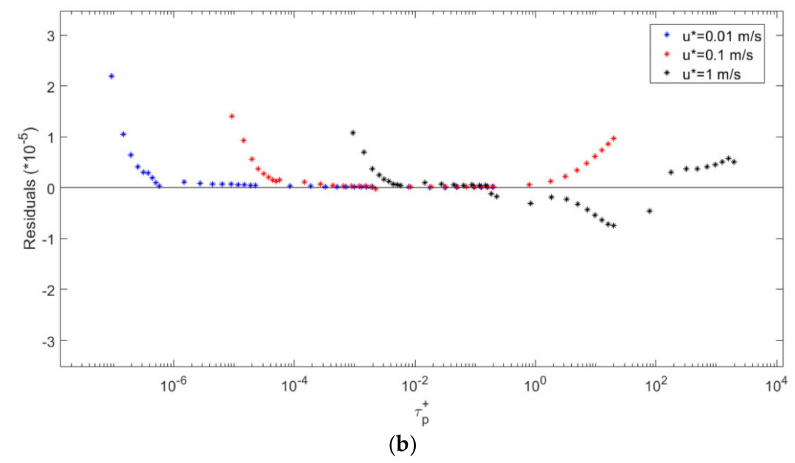
Figure 6. ( a ) A comparison, for Fickian diffusion only, between the optimized code (dashed curves) and the unoptimized code (solid curves) for dry deposition velocity V + d . ( b ) the residuals between both codes.